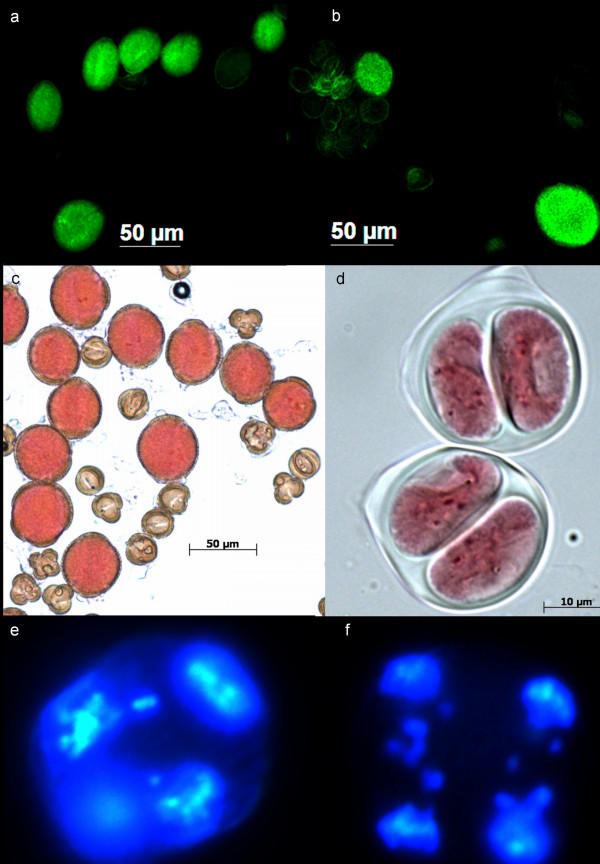
Male unreduced gamete formation in Brassica. a) A "giant" pollen grain in B. napus and several normal sized pollen grains; b) Putative viable unreduced (large, bright), viable reduced (small, bright) pollen and non-viable (shrunken, dull) pollen in an interspecific hybrid; c) B. napus × B. carinata (CCAB) pollen in cold (10°C day/5°C night) temperature); d) Two dyads produced by a B. napus × B. carinata (CCAB) hybrid in cold (10°C day/5°C night) temperature; e) beginning of telophase II in an interspecific hybrid, showing a tetrahedral nuclei arrangement within the cell as a result of normal, perpendicular spindle orientation, but with laggard chromosomes outside the nuclei and f) Anaphase II showing parallel spindles, a common mechanism of dyad formation in Brassica.